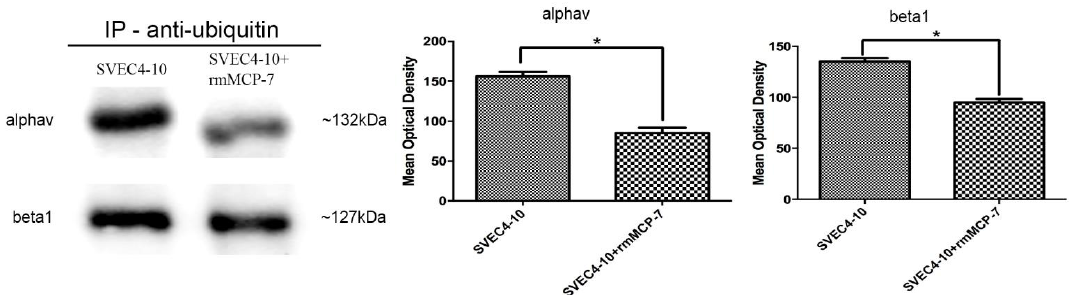
Figure 5. Both the αv and β1 subunits are ubiquitinated during angiogenesis in vitro. Note that the levels of integrin subunits are lower in the presence of rmMCP-7. Integrin levels were analyzed by Western blot after immunoprecipitation (IP) using anti-ubiquitin antibody after the tube-forming assay. Western blot bands were quantified by densitometry. Data from three independent experiments. * p < 0.05.